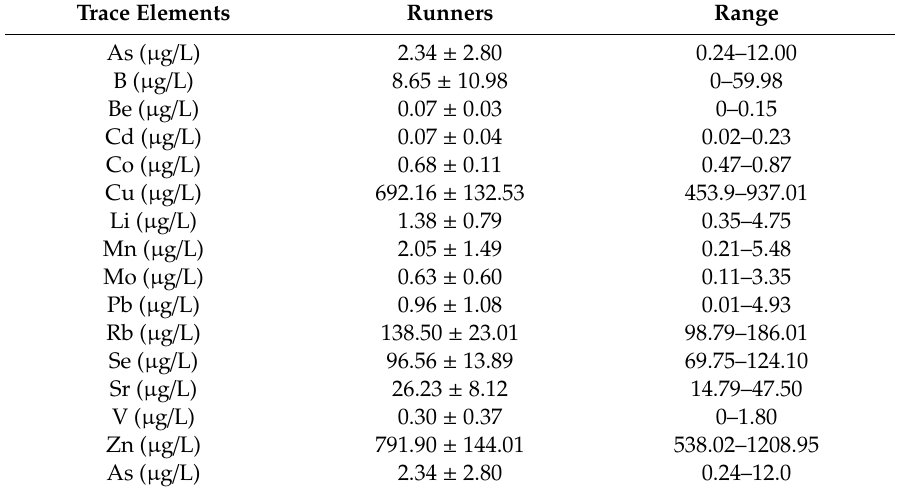
Table 3. Plasma concentrations of trace elements in the